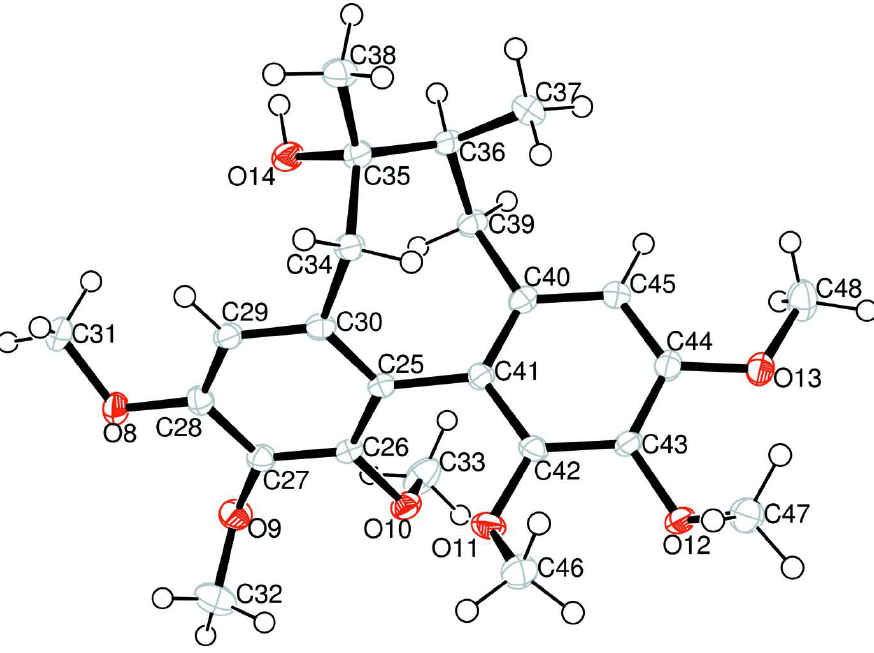
Figure 2 View of the second molecule in the asymmetric unit with the atom-numbering scheme and 50% probability displacement